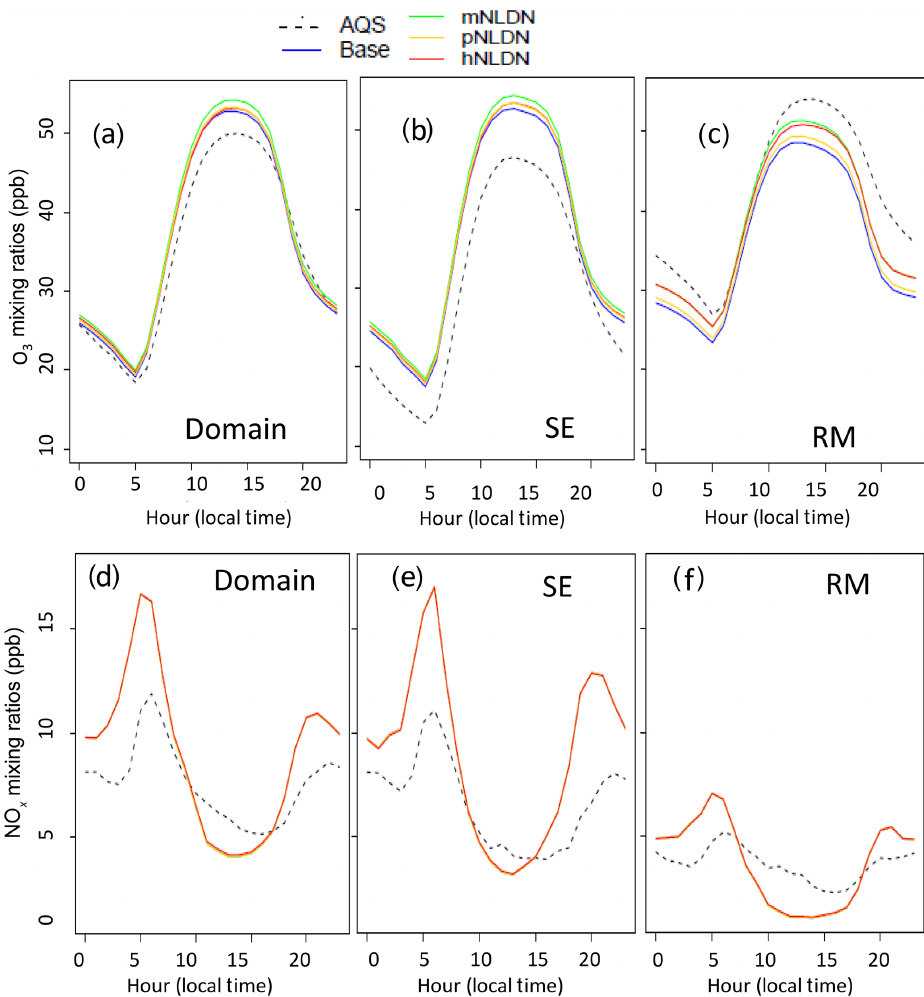
Figure 4. Diurnal profiles for hourly O 3 and NO x over the domain (a, d) , SE (b, e) , and RM (c, f) in July